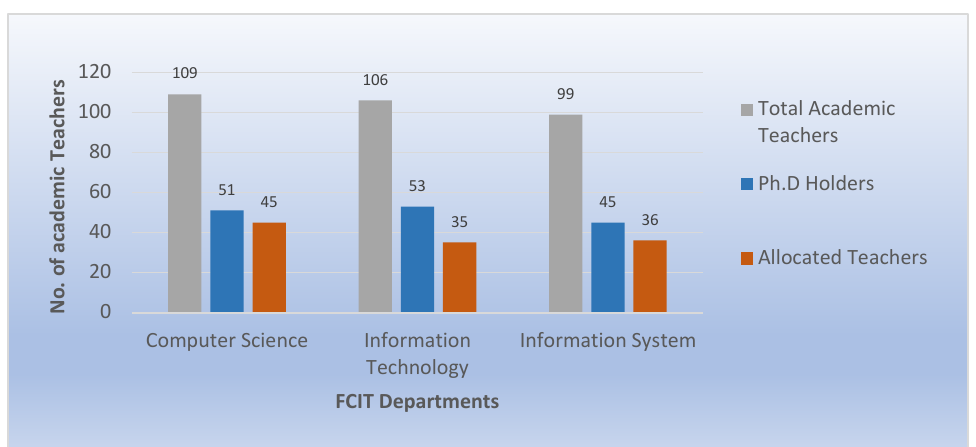
Figure 18. Comparing number of allocated teachers using LD to the total number of teachers.